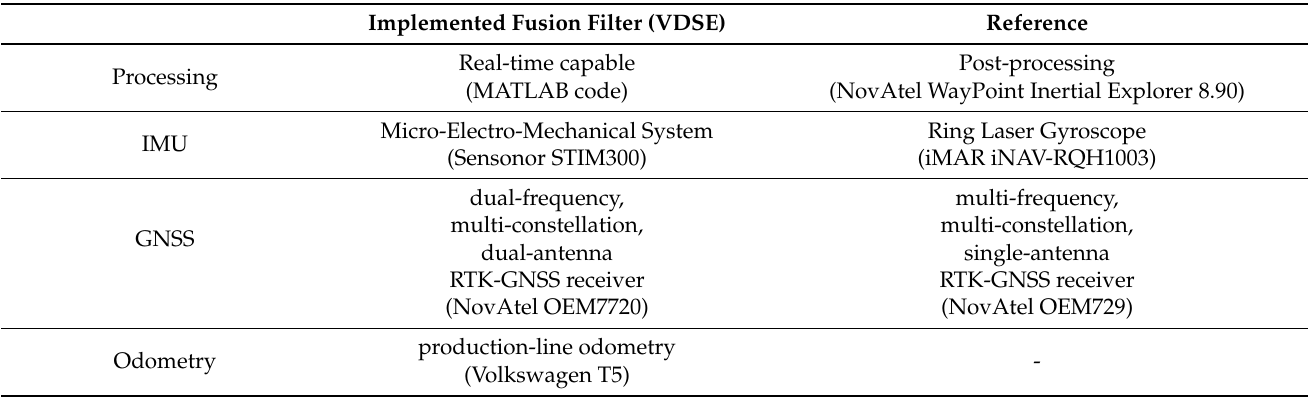
Table 5. Sensors and processing of the fusion filter of the vehicle dynamic state estimation of UNICAR agil used to compare the implemented integrity algorithms and of the reference solution.